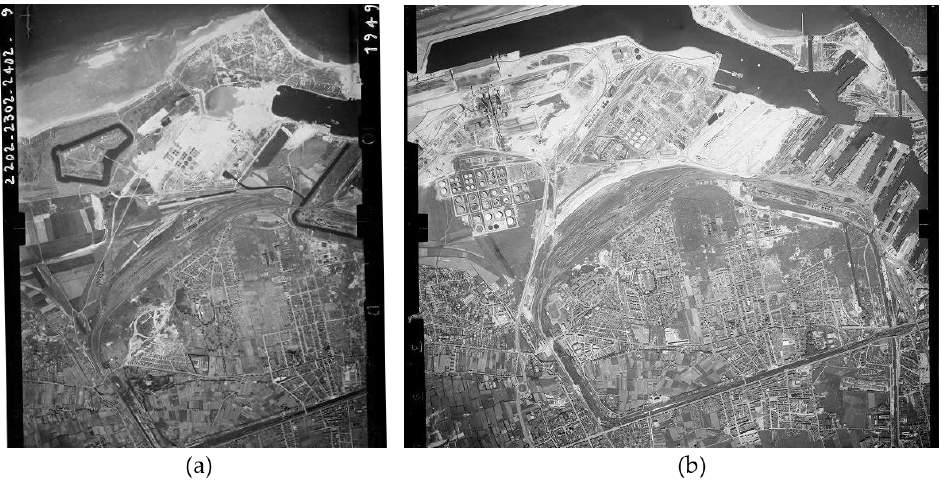
Figure 2. Aerial picture of the west part of the port of Dunkirk, Saint-Pol sur Mer. ( a ) The western part of the port city in 1949; ( b ) The western part of the port city in 1963. Pictures of the service “remonter le temps” from the French National Institute of Geographic and Forest Information (IGN).